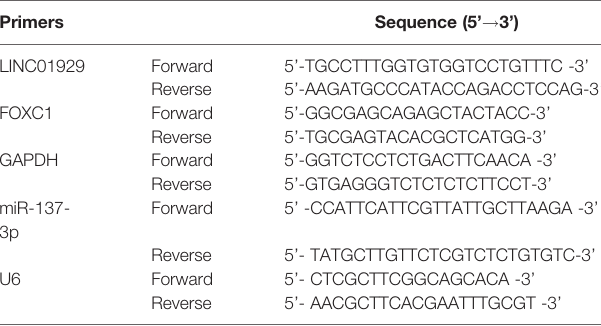
TABLE 1 | The primer of referred